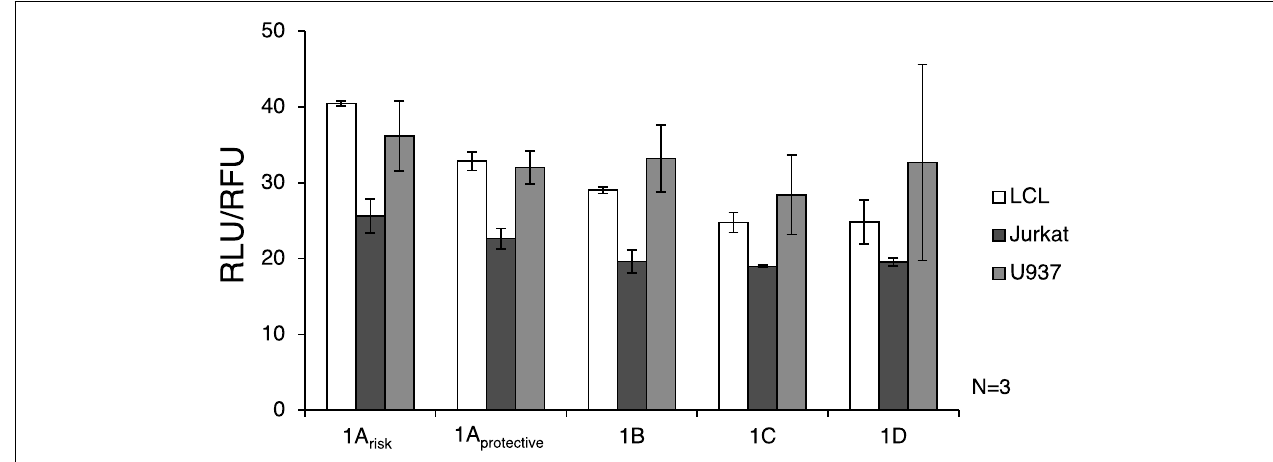
FIGURE 3 | Interferon regulatory factor 5 promoter activity in immune cells .The luciferase plasmids were transfected by electroporation of three cell types: LCL, U937 cells, and Jurkat cells. A control GFP-encoding plasmid was also used in each sample to normalize transfection